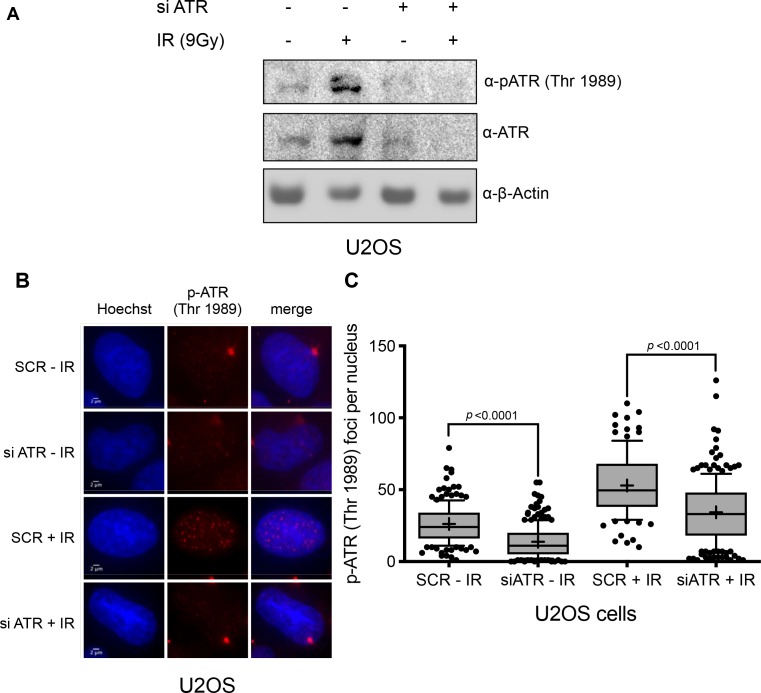
Validation of pATR antibody in U2OS cells.(A) Western blot demonstrating the specificity of the pATR-pT1989 phospho-specific antibody used for immunofluorescence. The strong band observed in irradiated U2OS cells treated with a control siRNA is not present in irradiated cells treated with a specific siRNA to ATR. (B) Immunofluorescent foci of pATR are evident in irradiated U2OS cells treated with a scrambled control siRNA and to a lesser extent in similarly treated unirradiated cells. Transfection with an siRNA targeting ATR significantly diminishes the observation of pATR foci in both irradiated and non-irradiated cells. Scale bar, 2 µm. (C) Statistical analysis of images exemplified in B. Boxplots (right) represent the pATR foci counts per nucleus. The median, mean (+), 10–90 percentiles and outliers are presented. The pATR foci formation decrease after knockdown is considered significant (p<0.0001) by a Mann-Whitney test. More than 100 nuclei were counted for each case.